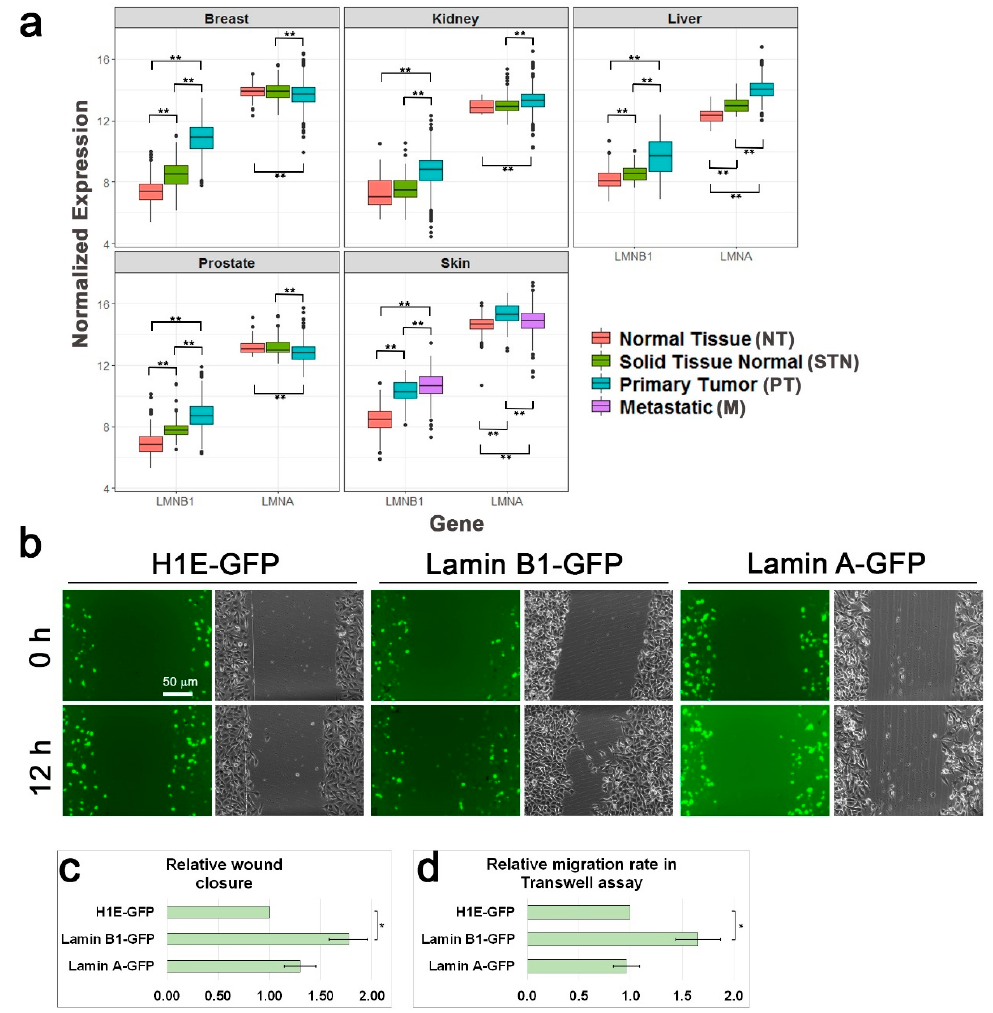
Figure 1. Increased lamin B1 levels in cancer accelerate cell migration. ( a ) Cancer is associated with higher expression levels of lamin B1. Relative RNA levels of lamin A ( LMNA gene) and lamin B1 ( LMNB1 gene) in the indicated human organs in normal tissues (NT), normal tissues around a tumor (STN), primary tumors (PT), and metastases (M) according to the available data in GTEx and TCGA databases. Patients no.: breast, NT-179, STN-113, PT-1092; kidney, NT-27, STN-140, PT-884; liver, NT-110, STN-50, PT-369; prostate, NT-100, STN-52, PT-495; skin, NT-556, PT-102, M-366; Statistical significance was evaluated by the Student’s t -test, ** p < 0.01 ( b ) Relative migration rate of B16–F10 cells over-expressing GFP-fused histone H1E, lamin A and lamin B1 in the wound healing assay. Representative GFP and phase-contrast micrographs of the same fields at time 0 (immediately after the scratch) and 12 h later. Scale bar: 50 μ m. ( c ) The area covered by the cells following 12 h of incubation was measured and set as 1 for the over-expressing H1E-GFP cells. The graphs show the mean area covered in five independent experiments ± s.e. Statistical significance was evaluated by the Student’s t -test, * p < 0.05. ( d ) Over-expression of lamin B1 accelerates the migration rate of B16–F10 in the Transwell assay. The migration rate of B16–F10 cells over-expressing H1E-GFP, lamin B1-GFP, and lamin A-GFP was measured by the Transwell assay. Four hours after plating the cells on top of the filters the cells were fixed, permeabilized, and stained with Hoechst reagent. In each experiment the fraction of the transfected cells migrated to the lower side of the filter was calculated and normalized to the migration rate of H1E-GFP over-expressing cells. The graphs show the mean relative migration rate in three independent experiments ± s.e. Statistical significance was evaluated by the Student’s t -test, * p < 0.05.